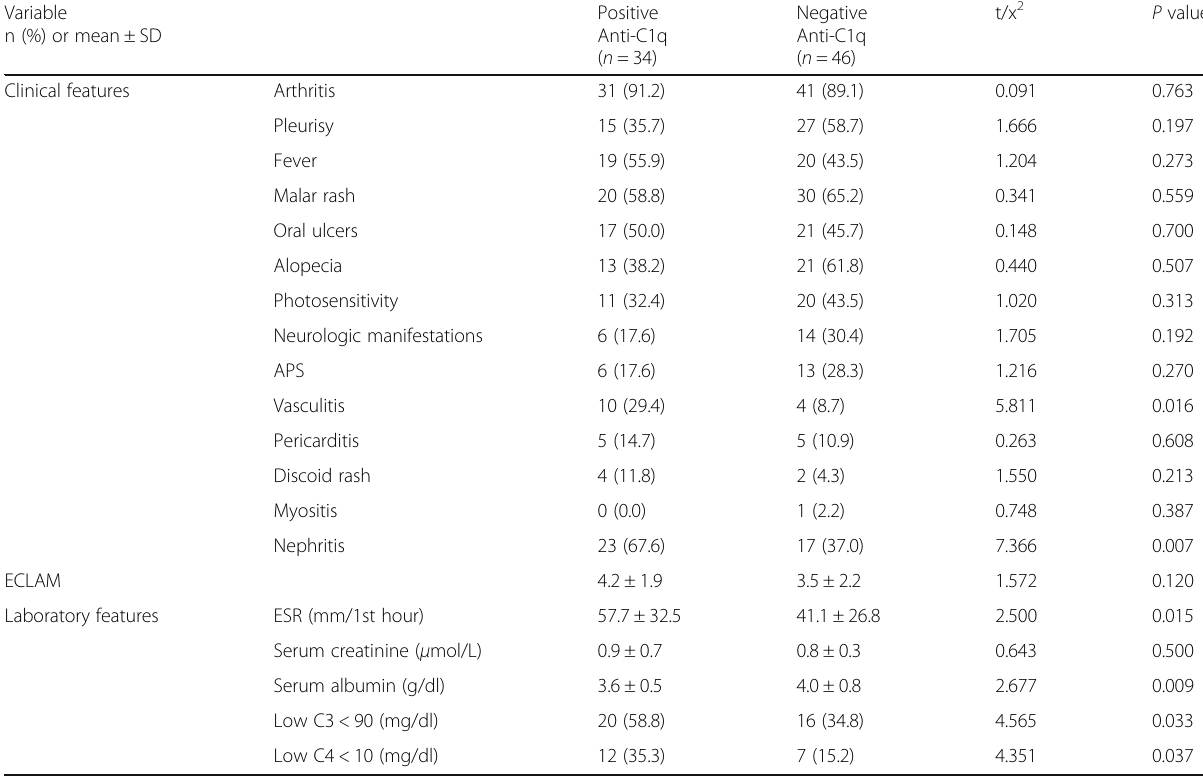
Table 4 Relationship between anti-C1q antibody and other disease parameters among patients under study Variable n (%) or mean ± SD